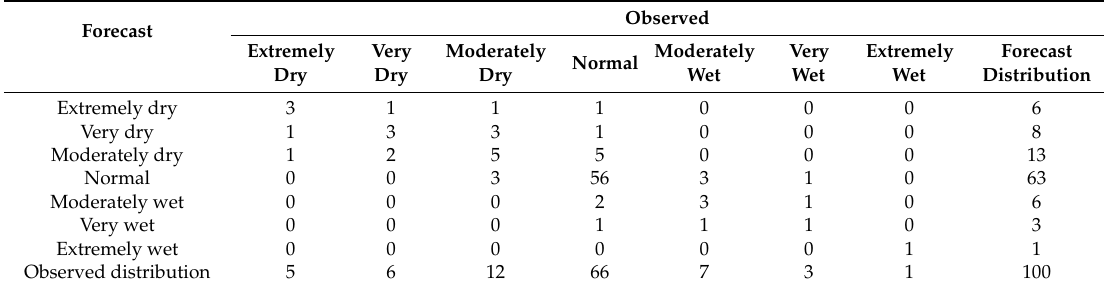
Table 2. Relative frequency (in percent) for the standardized precipitation index ( SPI ) 10-day forecasts ( n = 1330).